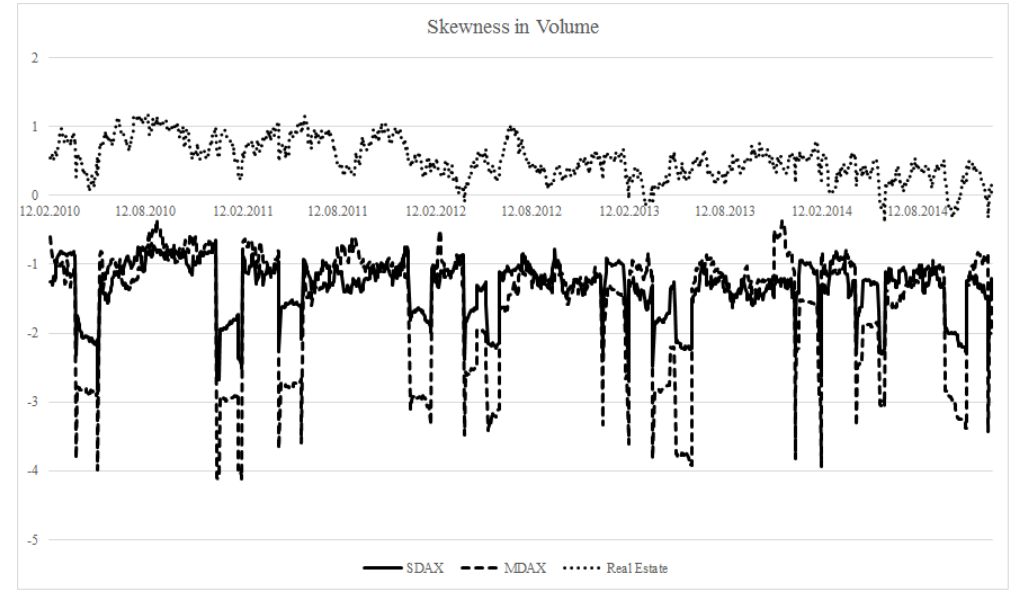
Figure 1. Estimates of rolling window skewness coefficients. The figure is a graphical representation of rolling window skewness coefficients averaged for the sub-samples of real estate stocks, as well as the constituents of the MDAX and the SDAX.